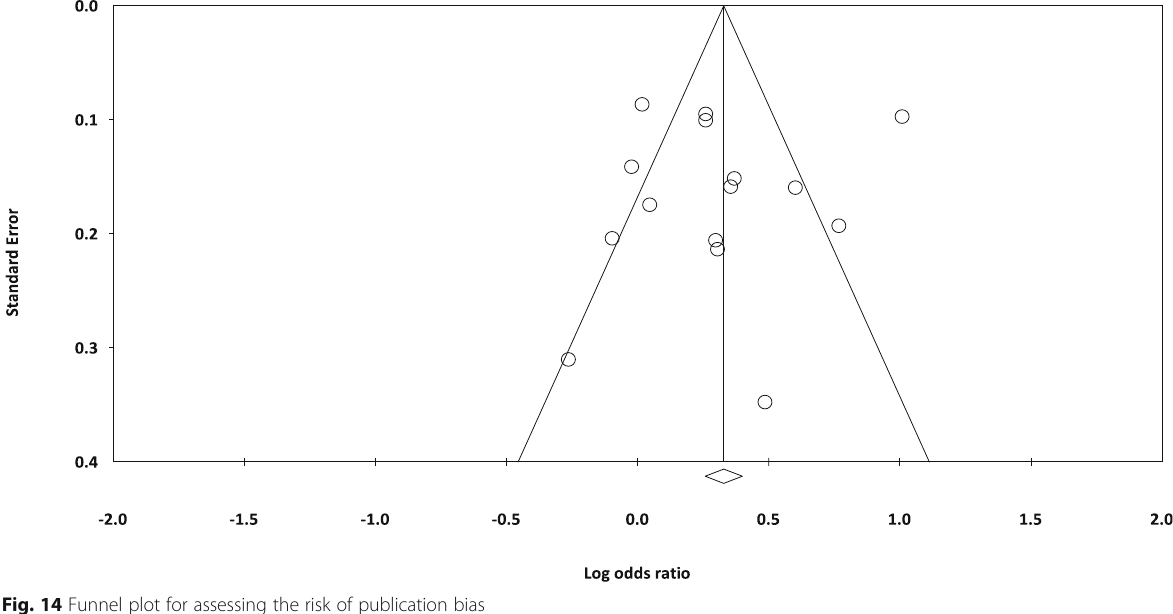
Fig. 14 Funnel plot for assessing the risk of publication